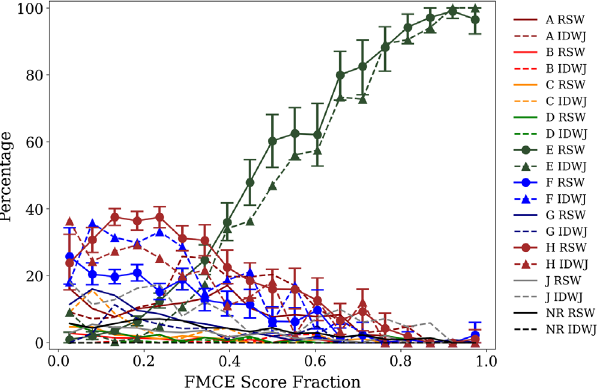
FIG. 9. Item 32 IRCs: the solid lines show the IRCs for the RSW dataset, and the dashed lines show the IRCs for the IDWJ dataset. NR ¼ no response. The error bars on B, E, and F RSW IRCs are the 95% confidence intervals of 10 000 bootstrapped sample datasets based on RSW data described in Sec. III